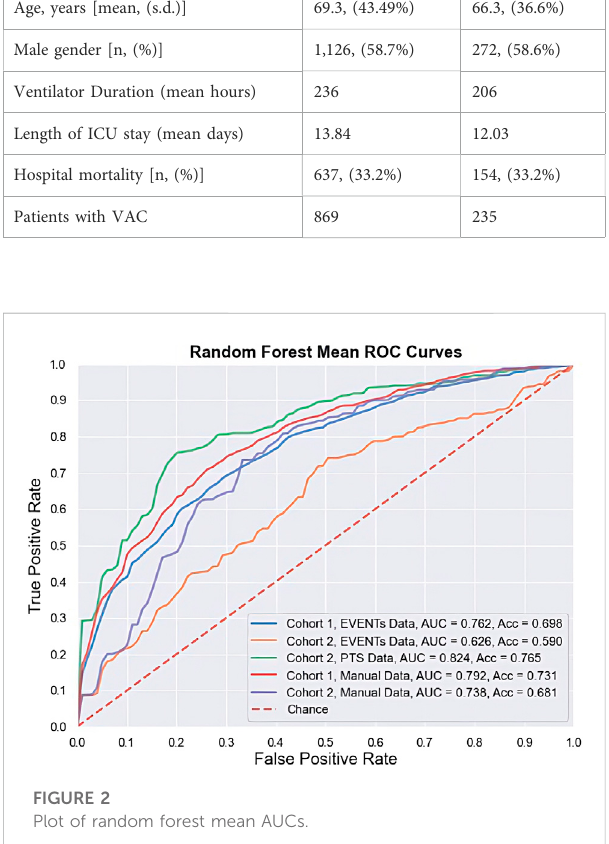
FIGURE 2 Plot of random forest mean